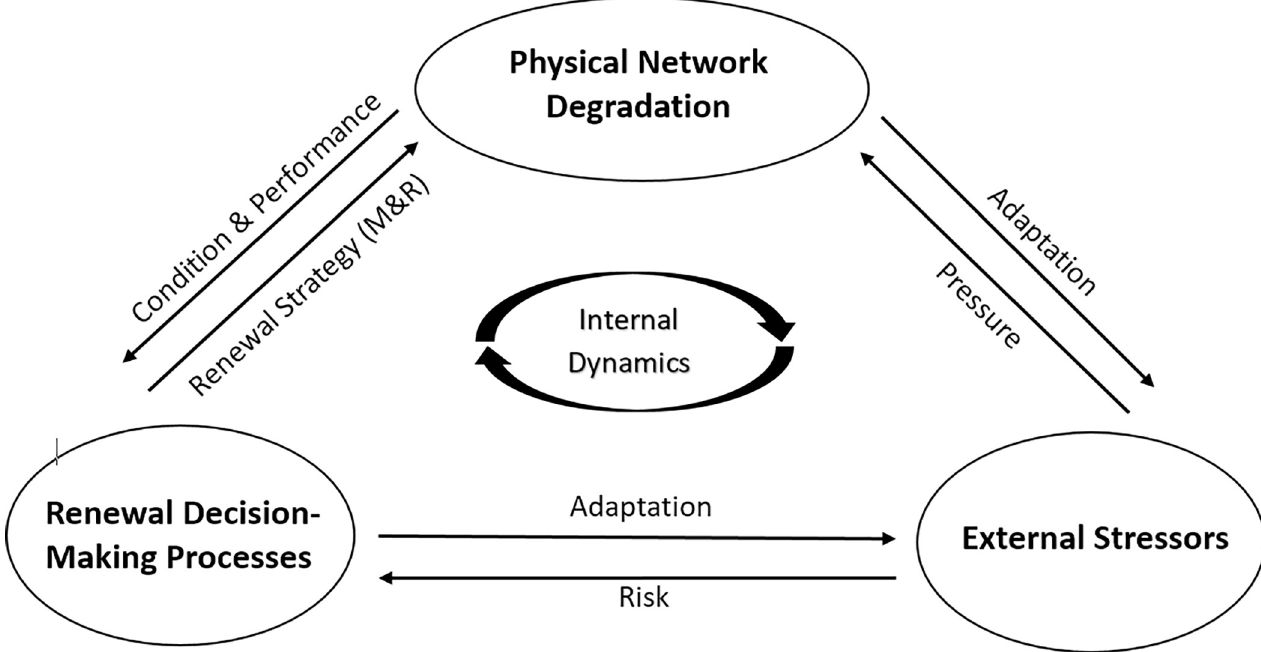
Fig 3. Conceptual modeling framework for water distribution infrastructure